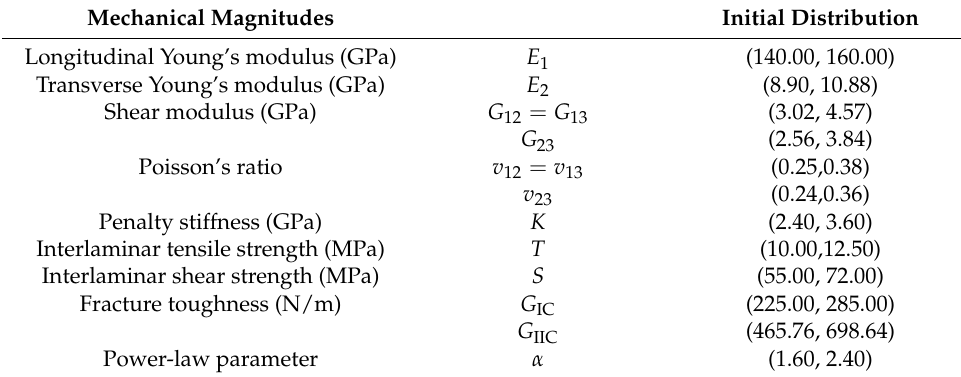
Table 1. Laminate material properties.